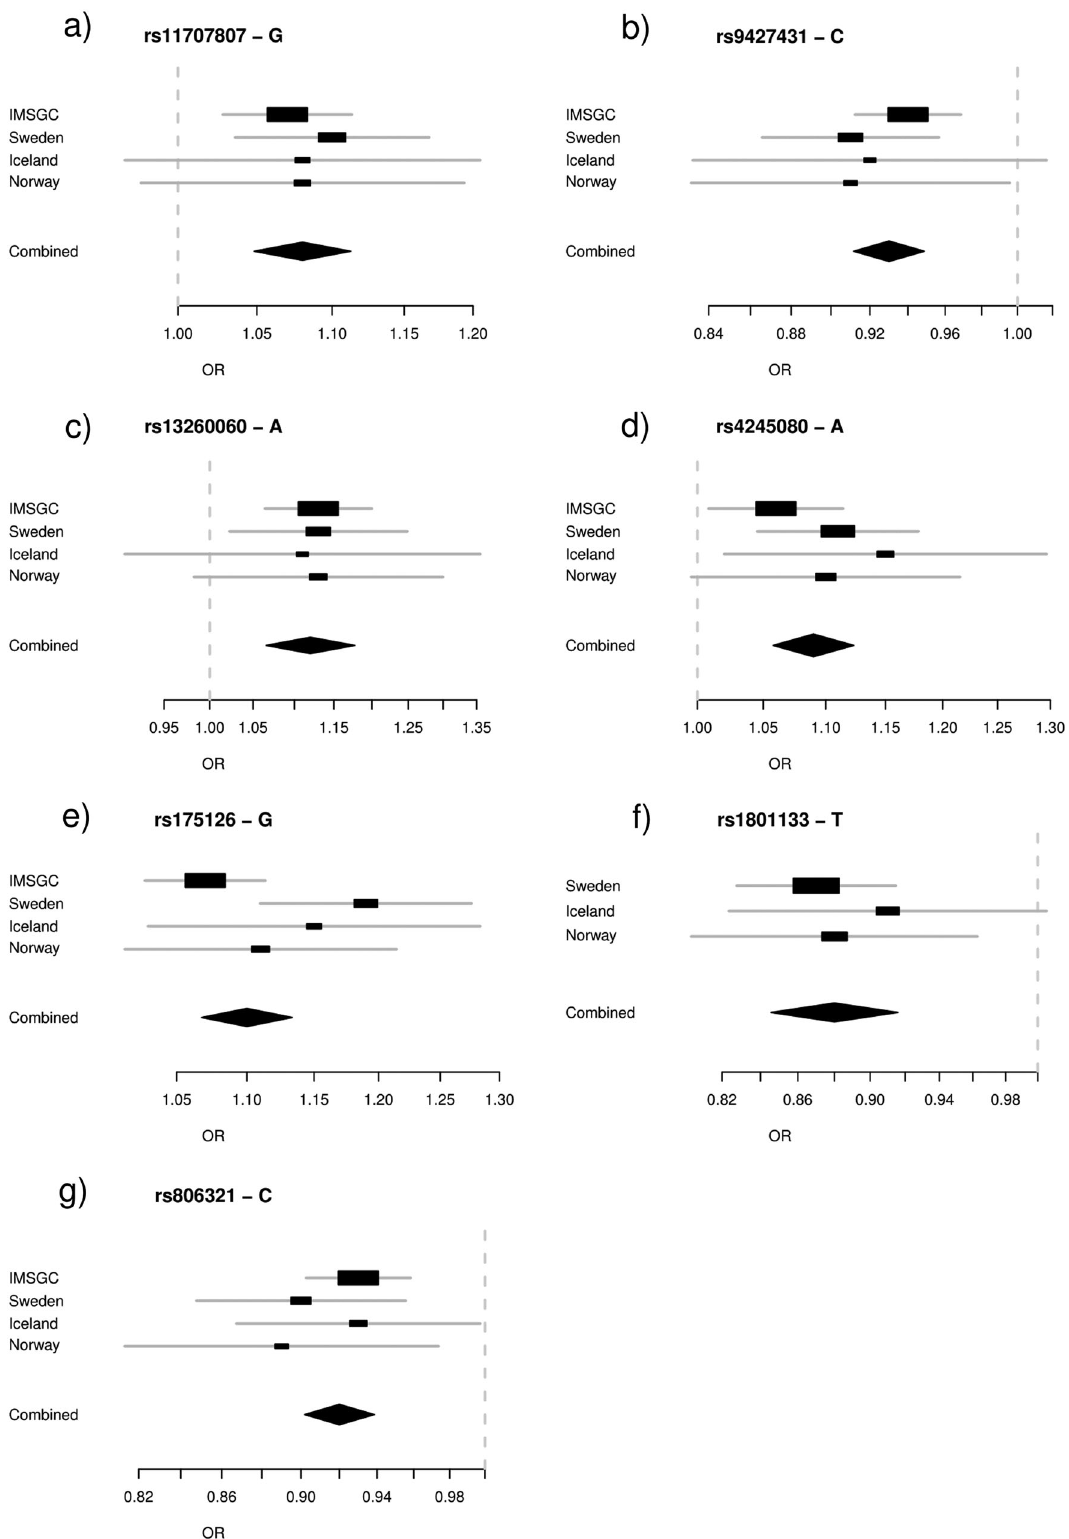
Fig. 1 Forest plot for variants discovered in a meta-analysis of MS cohorts. a rs11707807; b rs9427431; c rs13260060; d rs4245080; e rs175126; f rs1801133; g